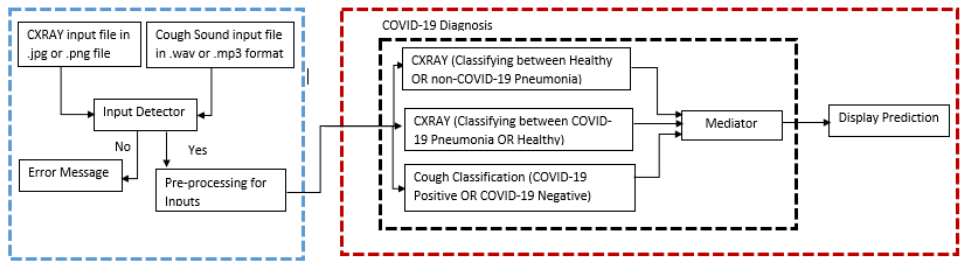
Figure 1. COVIDNet Implemented Parallel Architecture.